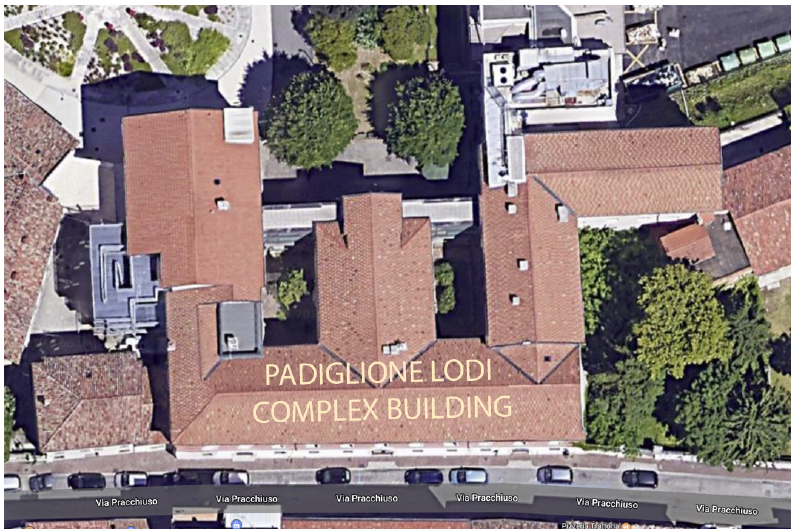
Figure 1. Top view of the “Padiglione Lodi” building